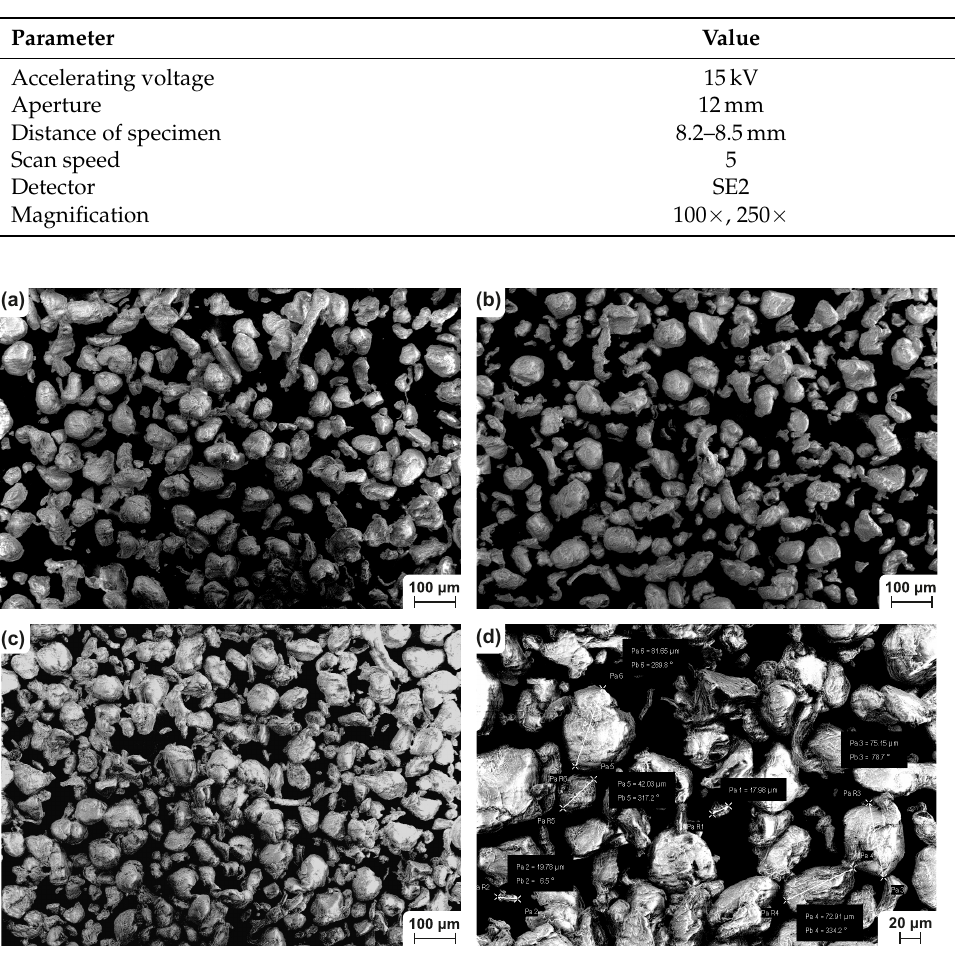
Figure 2. SEM images of PP powder: ( a ) new; ( b ) used; ( c ) and ( d )